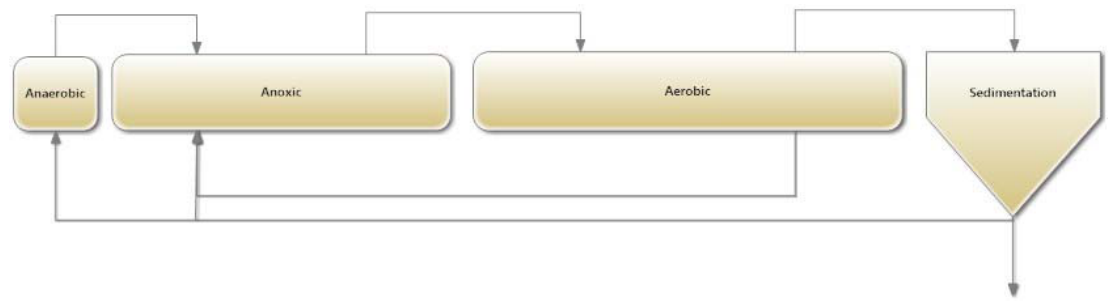
Figure 3. Municipal wastewater treatment plant (WWTP ‐ 3)